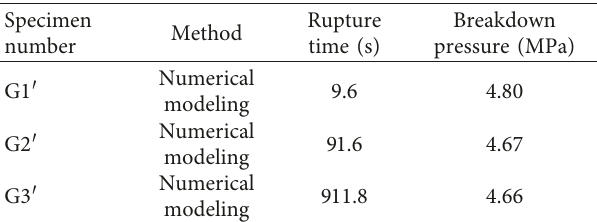
Table 9: The numerical results of rupture time and breakdown pressure with the nitrogen gas